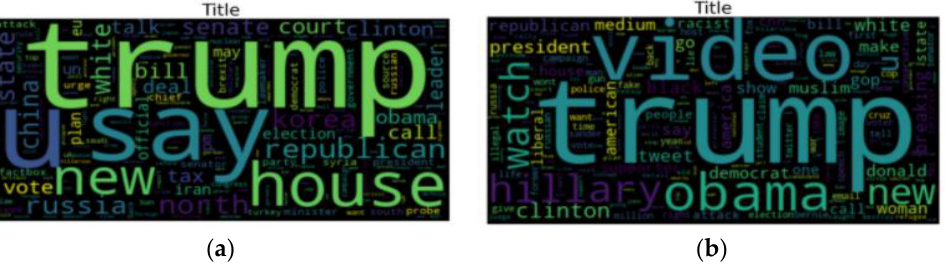
Figure 3. Word clouds comprising title words for the fake and real new samples; ( a ) word cloud of frequently occurring title words from real news samples; ( b ) word cloud of frequently occurring title words from fake news samples.